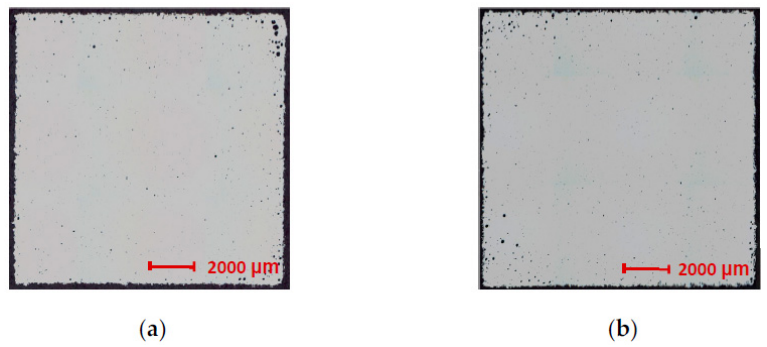
Figure 8. Test of bulk samples II, plane XY, ( a ) 5-4.1; ( b ) 5-4.4.